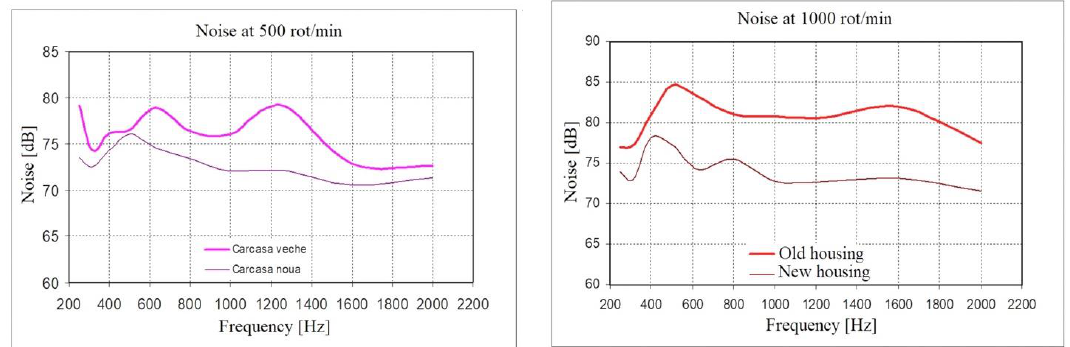
Figure 32. Lp sound pressure level diagrams for rear surface at 500 and 1000 rpm.